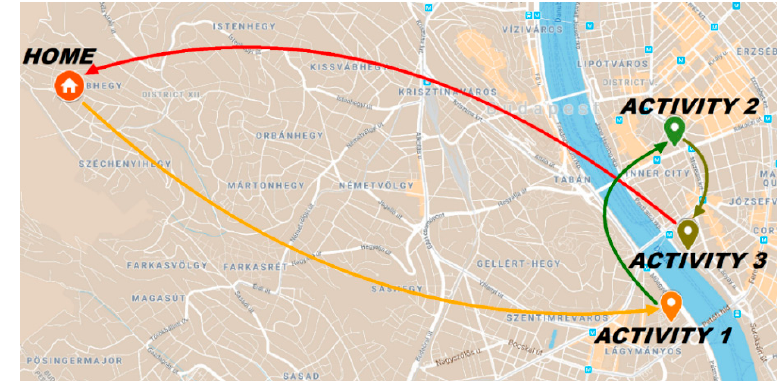
Figure 6. Initial activity chain of the traveler for case 3. Energies 2020 , 13 , 906 17 of 21